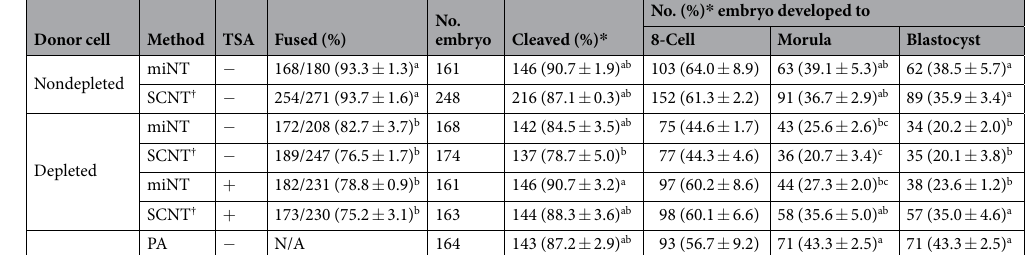
Supplementary Table 1. Analysis of downstream effects was performed using Ingenuity Pathway Analysis (IPA) to identify biological activities influenced by the DEGs. The most affected molecular and cellular function was cellular development, whilst the top annotation for physiological system, development and function was organ- ismal survival (Fig. 2a). The annotated functions with a significant activation z-score are listed in Supplementary Table 2. The formation of spindle apparatus and mitotic spindle, and recombination of cells were predicted to increase. Cell viability and movement, ubiquitination of protein, metabolism of DNA, and DNA replication and translation were predicted to decrease. The top five networks identified from the DEGs, which had IPA scores (-log(P-value)) ranging from 36 to 40, are listed in Supplementary Table 3. Fourteen upregulated DEGs and 15 downregulated DEGs were involved in gene expression, cell morphology, and cellular and maintenance functions (Fig. 2b). The most significantly affected canonical pathway was the ‘epithelial adherens junction signalling’ path- way. The top five canonical pathways are shown in Fig. 2c. Using upstream regulation analysis, CD24 and other three other transcription regulators (TCF7L2, PAX7 and XBP1) were predicted to be inhibited (|z-score| > 2, P < 0.01, Fig. 2d) whilst CST5 was predicted to be activated.